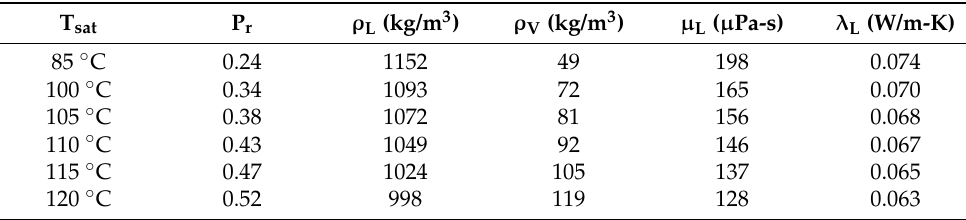
Table 2. Properties of R245fa at the present study’s experimental conditions.